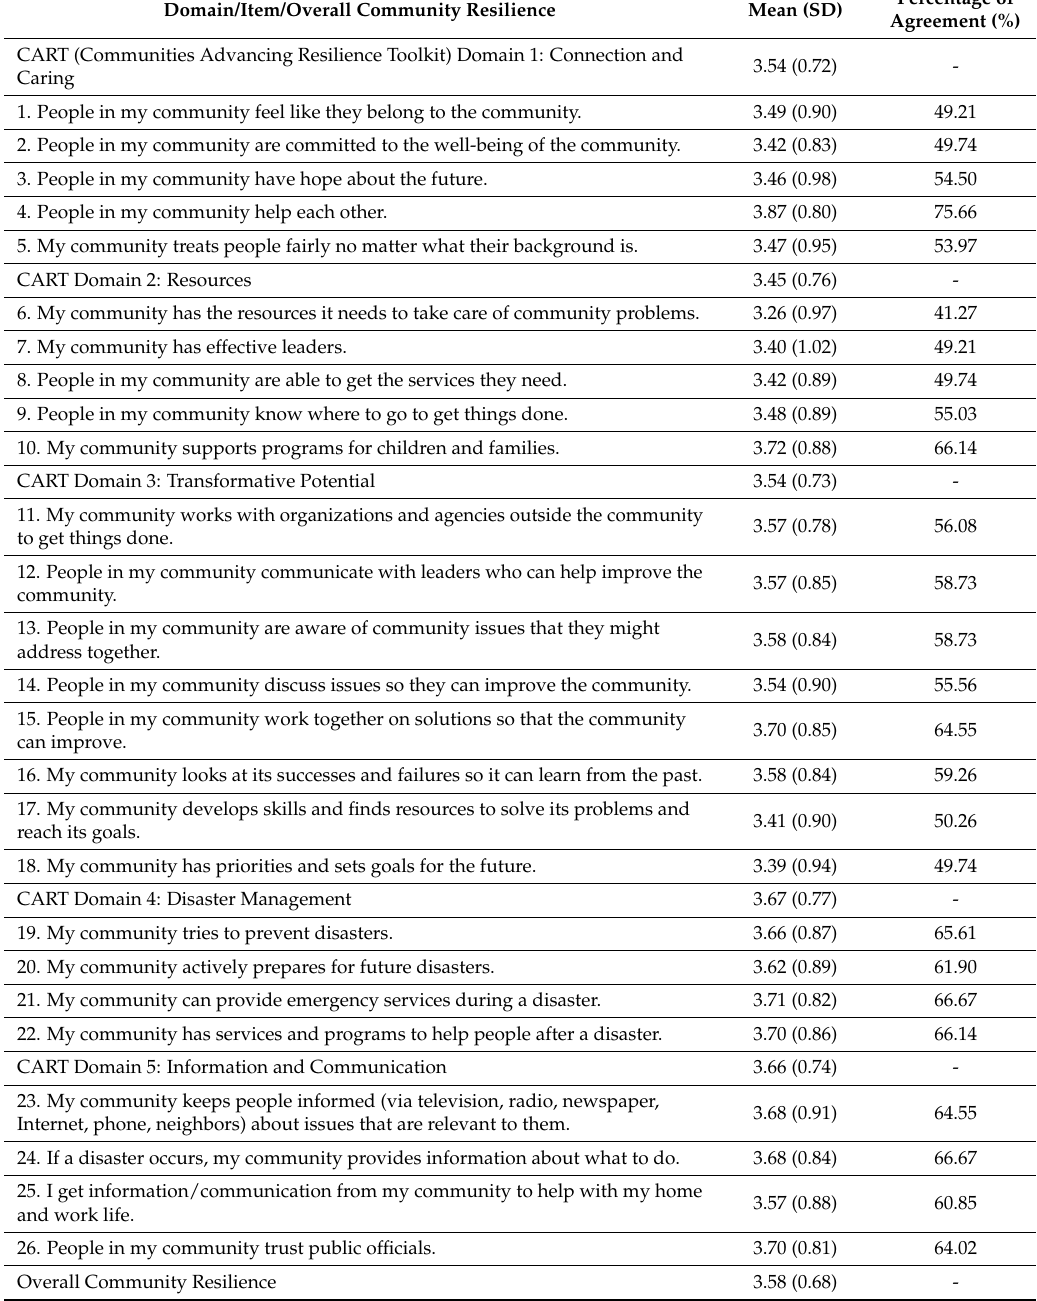
Table 2. Core community resilience items by domains and perceptions of community